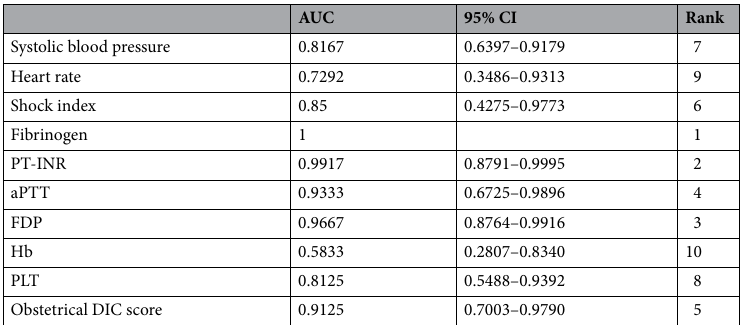
Table 3. Univariate analysis with ranks of haemostatic parameters at onset indicating correlation with AFE. PT-INR prothrombin-international normalised ratio, aPTT activated partial thromboplastin time,